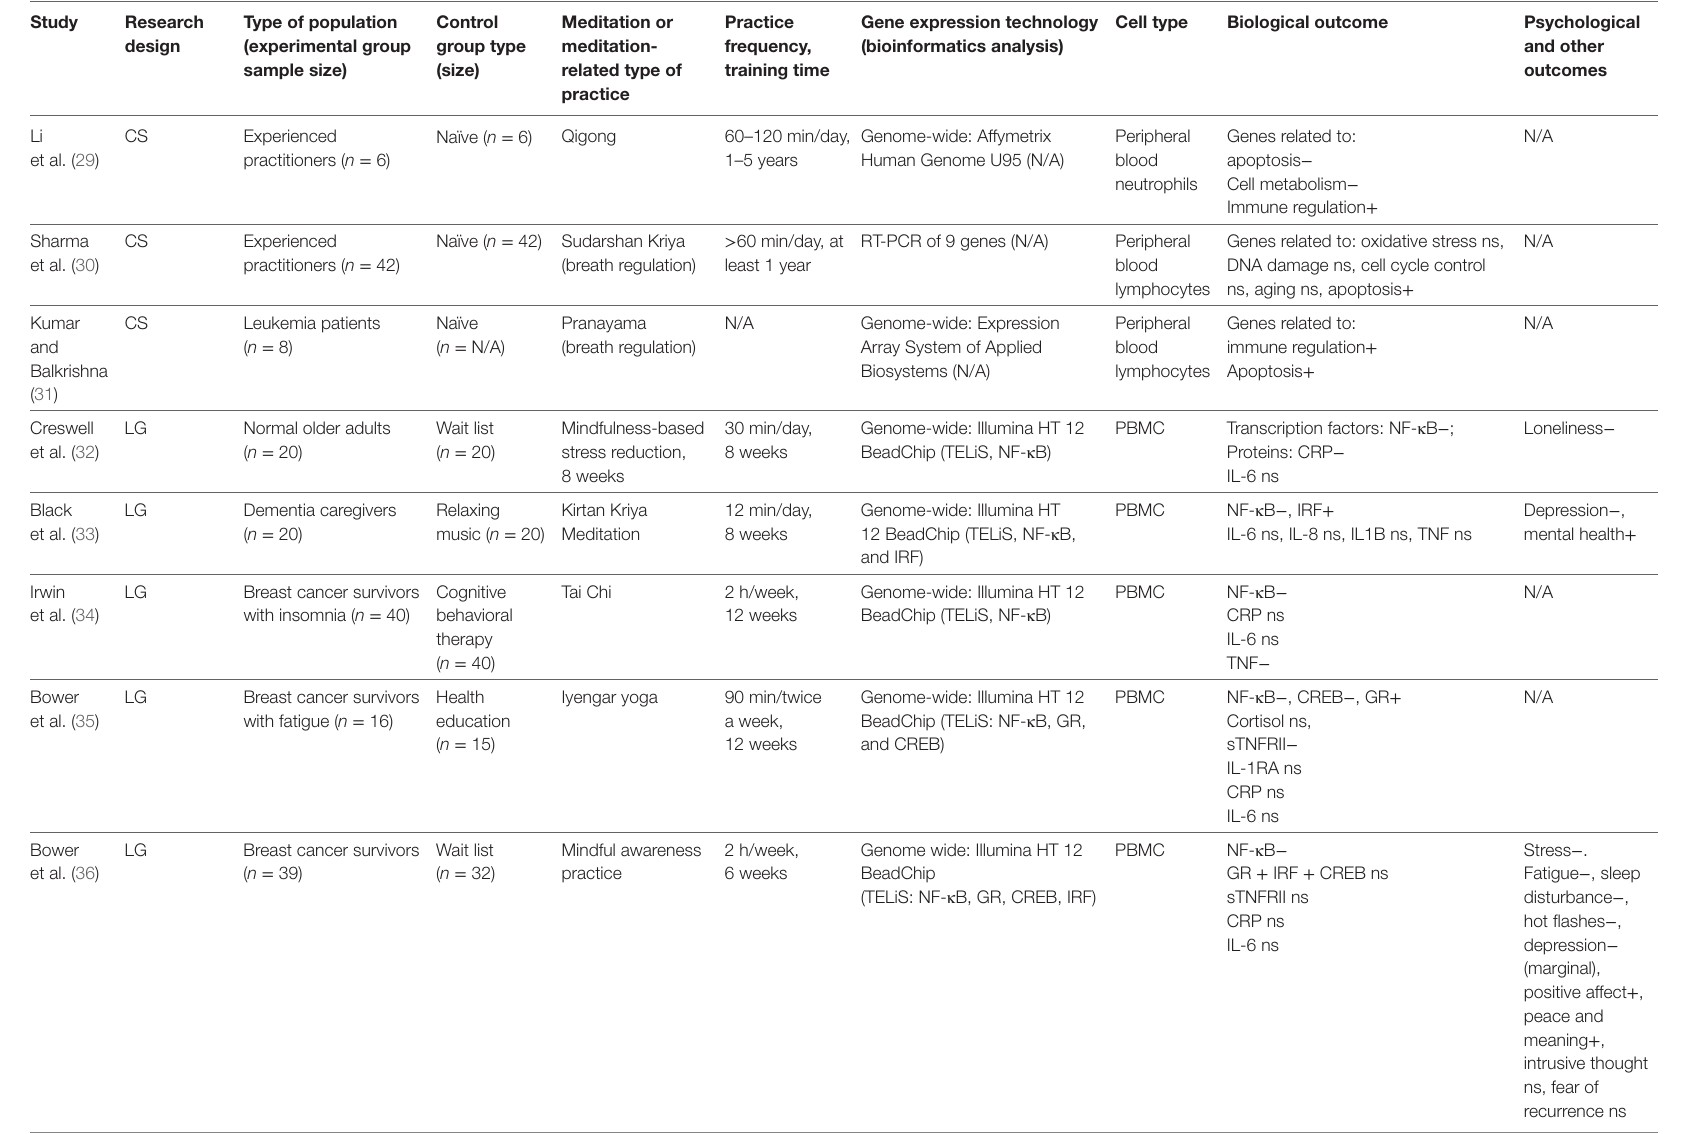
TABle 1 | A summary of the results of MBI and gene